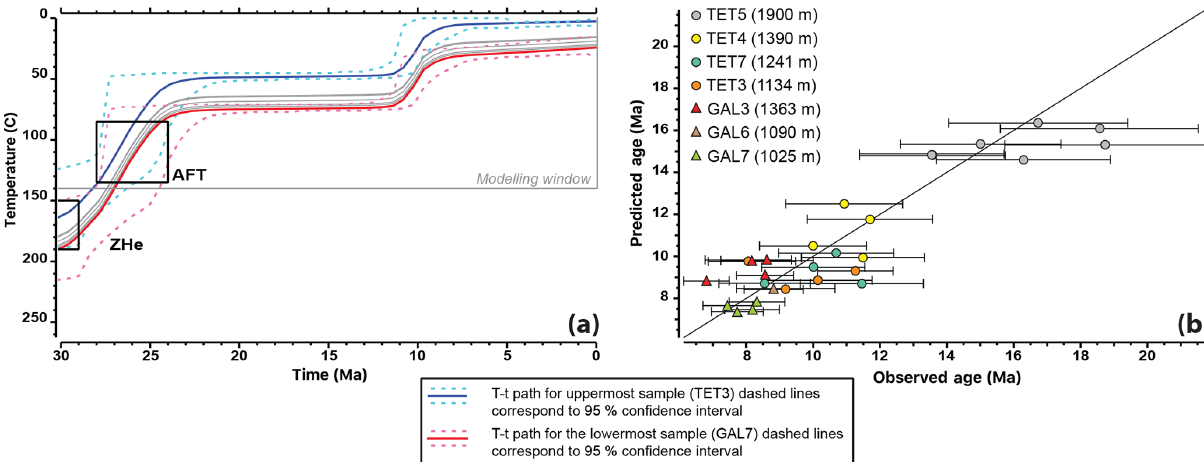
Figure 14. (a) Thermal history of the Têt fault footwall. Thermal modelling was computed with QTQt software (Gallagher, 2012) and Gautheron et al. (2009) diffusion parameters using AHe data from TET outside DZ samples and GAL DZ and outside DZ samples. AFT and ZHe data are from Maurel et al. (2008). (b) Predicted age vs. observed age graph for each apatite grain. The 1 : 1 diagonal line is for an ideal fit of these